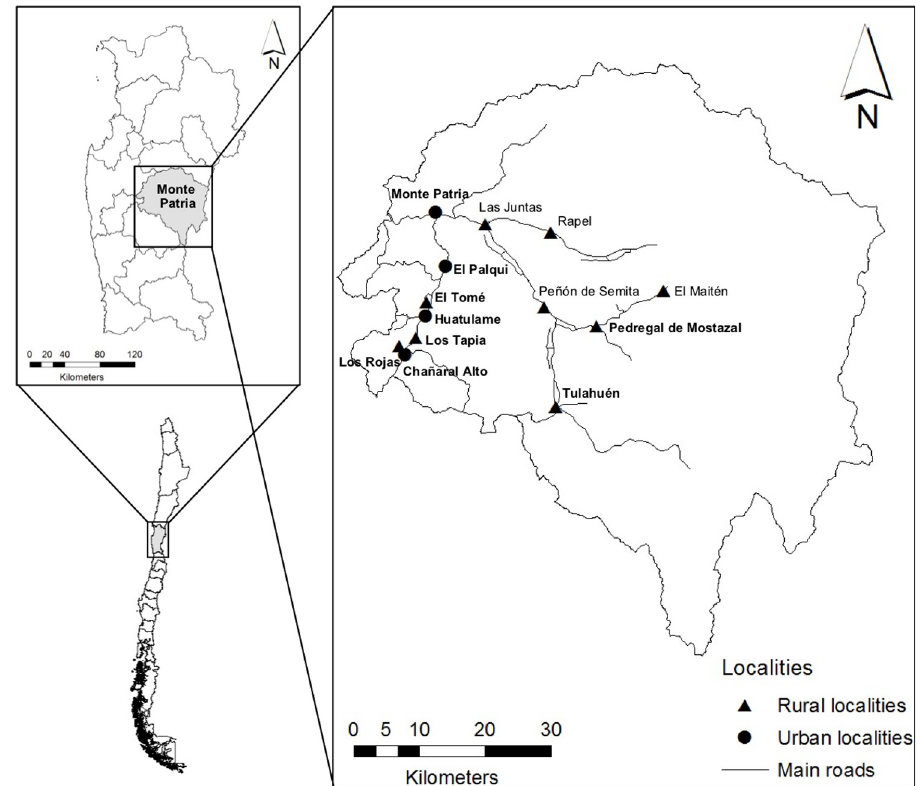
Fig 1. Map of localities of residence of volunteers screened by abdominal ultrasound in the Monte Patria municipality, Limarı´province, Coquimbo region, Chile. Locality names in bold indicate the places where the ultrasound screening hubs were set-up in the study area. (Map made in QGIS Geographic Information System. Open Source Geospatial Foundation Project. http://qgis.osgeo.org. Shapes downloaded from an open source from the Biblioteca del Congreso Nacional, Available at https://www.bcn.cl/siit/mapas_vectoriales/index_html).